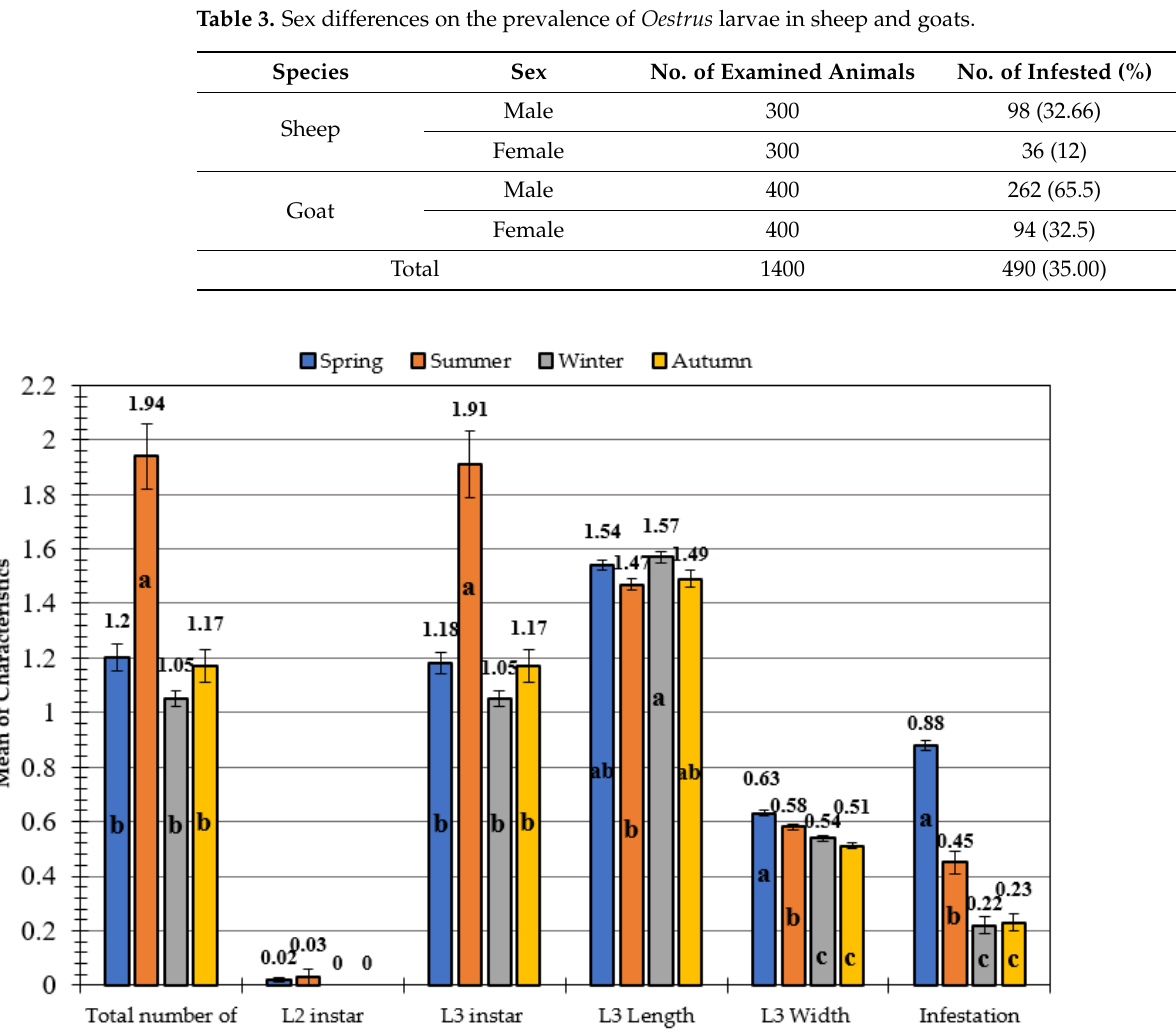
Table 2. Prevalence of Oestrus larvae in sheep and goats over the course of the study.